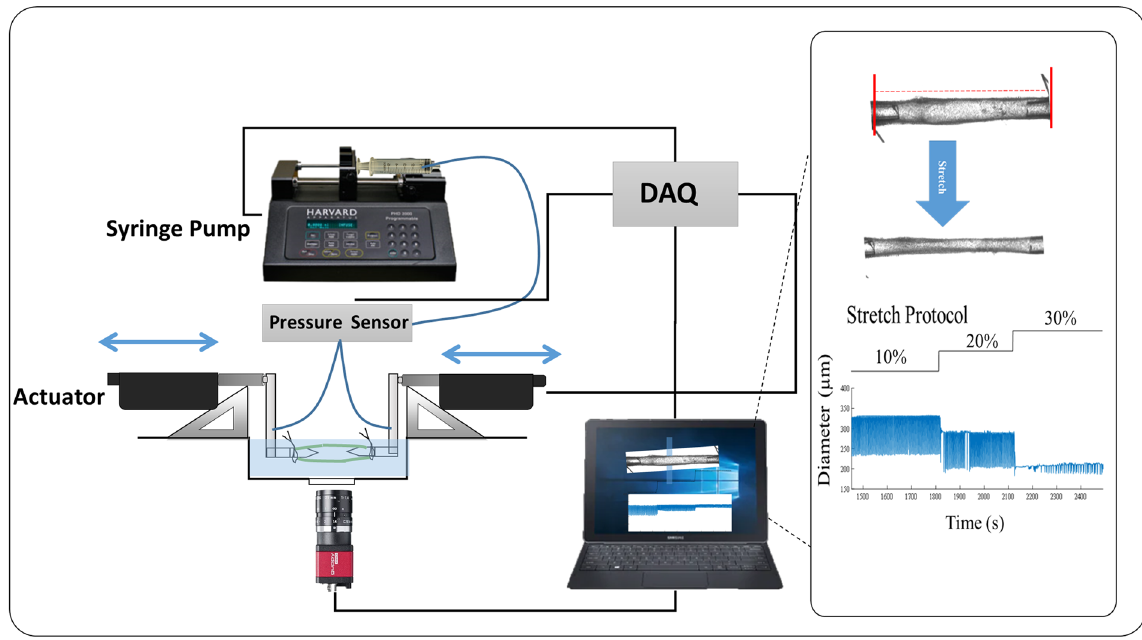
Figure 2. A schematic diagram of ex-vivo measurement of axial stretch using ex vivo setup. The vessel was pressurized using a syringe pump at ~0.5 mmHg to determine the minimum length at which the vessel does not bend (unloaded length). Length was measured using a LabView program and axial stretch was determined with respect to unloaded length and actuators were used to change axial stretch. A custom-written LabView program was used to track contractions as a function of time. An image of a rat tail lymphatic vessel cannulated on glass micropipettes along with respective raw traces of contractions at different stretches are